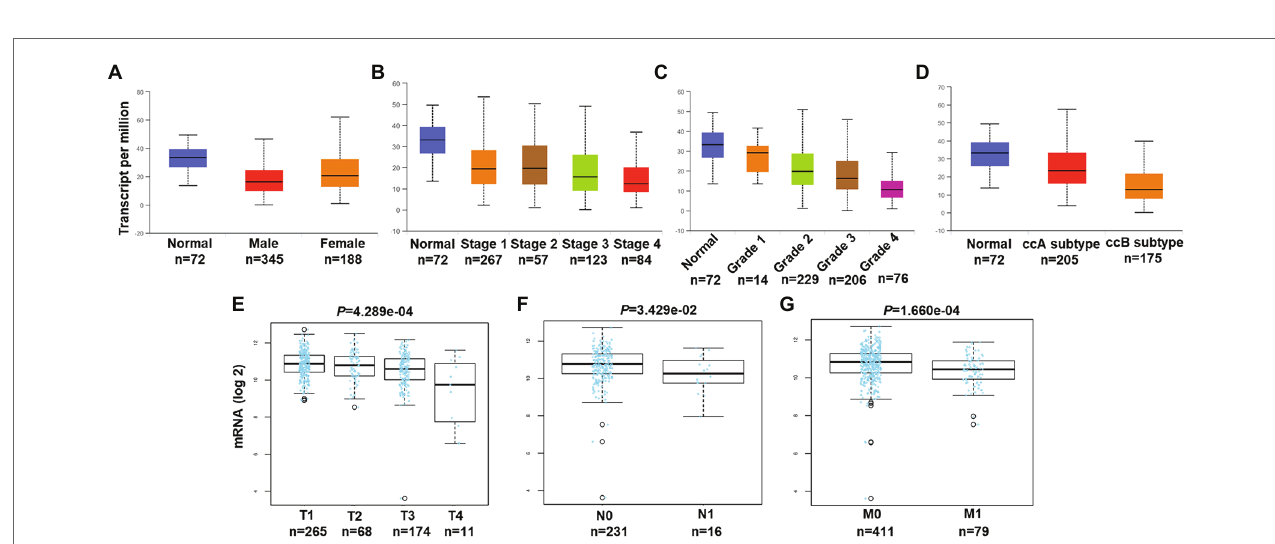
FIGURE 2 | Association of PATJ mRNA level with pathological features from ccRCC patients. (A) Association of PATJ mRNA with patients’ gender. (B) PATJ mRNA with ccRCC stages. (C) PATJ mRNA with ccRCC grades. (D) PATJ mRNA with ccRCC subtypes. The box plots and p ( Table 2 ) in A–D were generated by using the UALCAN (http://ualcan.path.uab.edu/index.html). (E) PATJ mRNA with ccRCC T stage. (F) PATJ mRNA with ccRCC N stage. (G) PATJ mRNA with ccRCC M stage. The box plots and values p ( Table 2 ) in E–G were obtained from the LinkedOmics